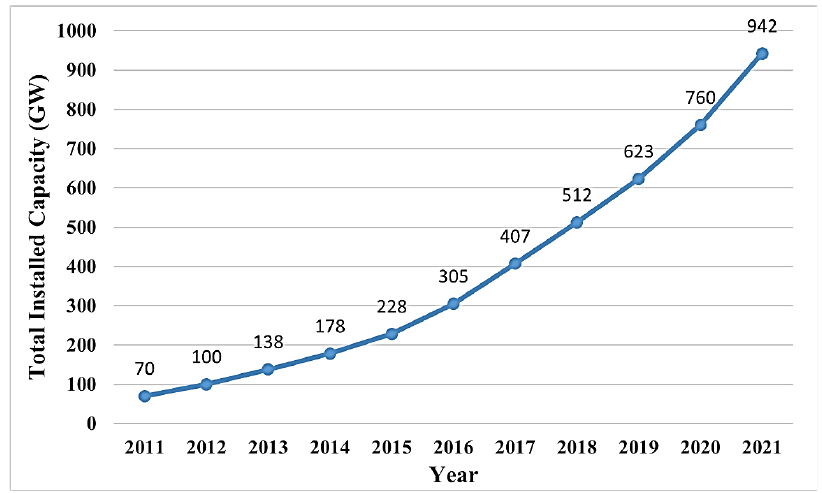
Figure 1. Global penetration of PV systems [6].